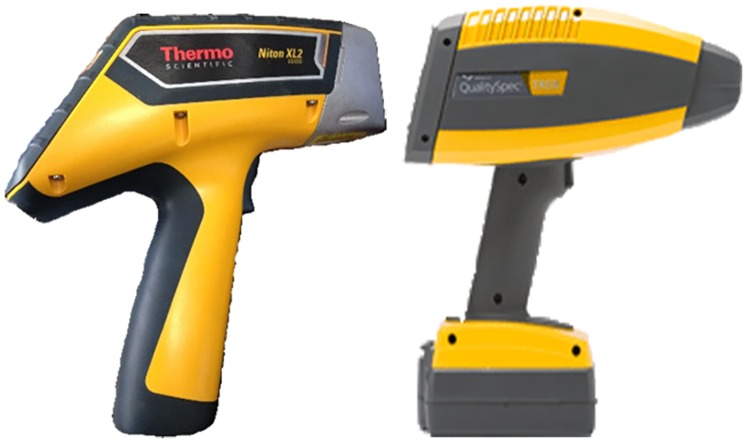
PXRF and portable VNIR analyzers.